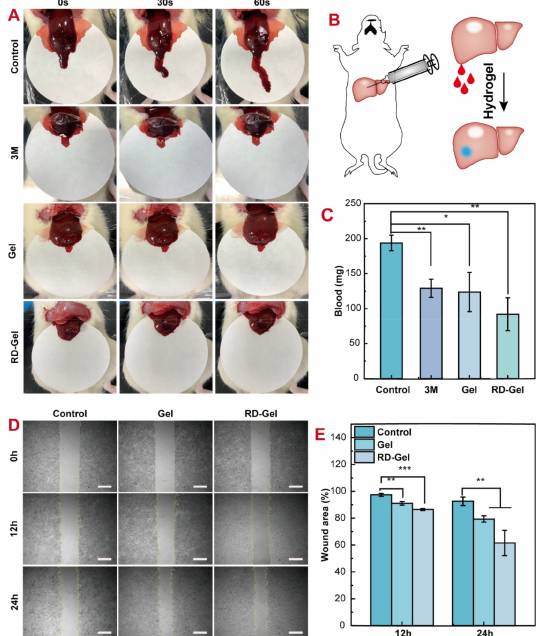
Figure 4. ( A ) Representative photographs of bleeding livers following different treatments at prede- termined time points. ( B ) A schematic illustration of a liver hemorrhage model. ( C ) Total mass of blood loss in 60 s from punctured livers. ( D ) Representative photographs of scratch wounds at 0 h, 12 h, and 24 h following the treatments with control, Gel, and RD-Gel. Scale bar: 100 µ m. ( E ) Wound area calculated (%) at 0 h, 12 h, and 24 h. For statistical analysis, * represents p < 0.05, ** represents p < 0.01, *** represents p <